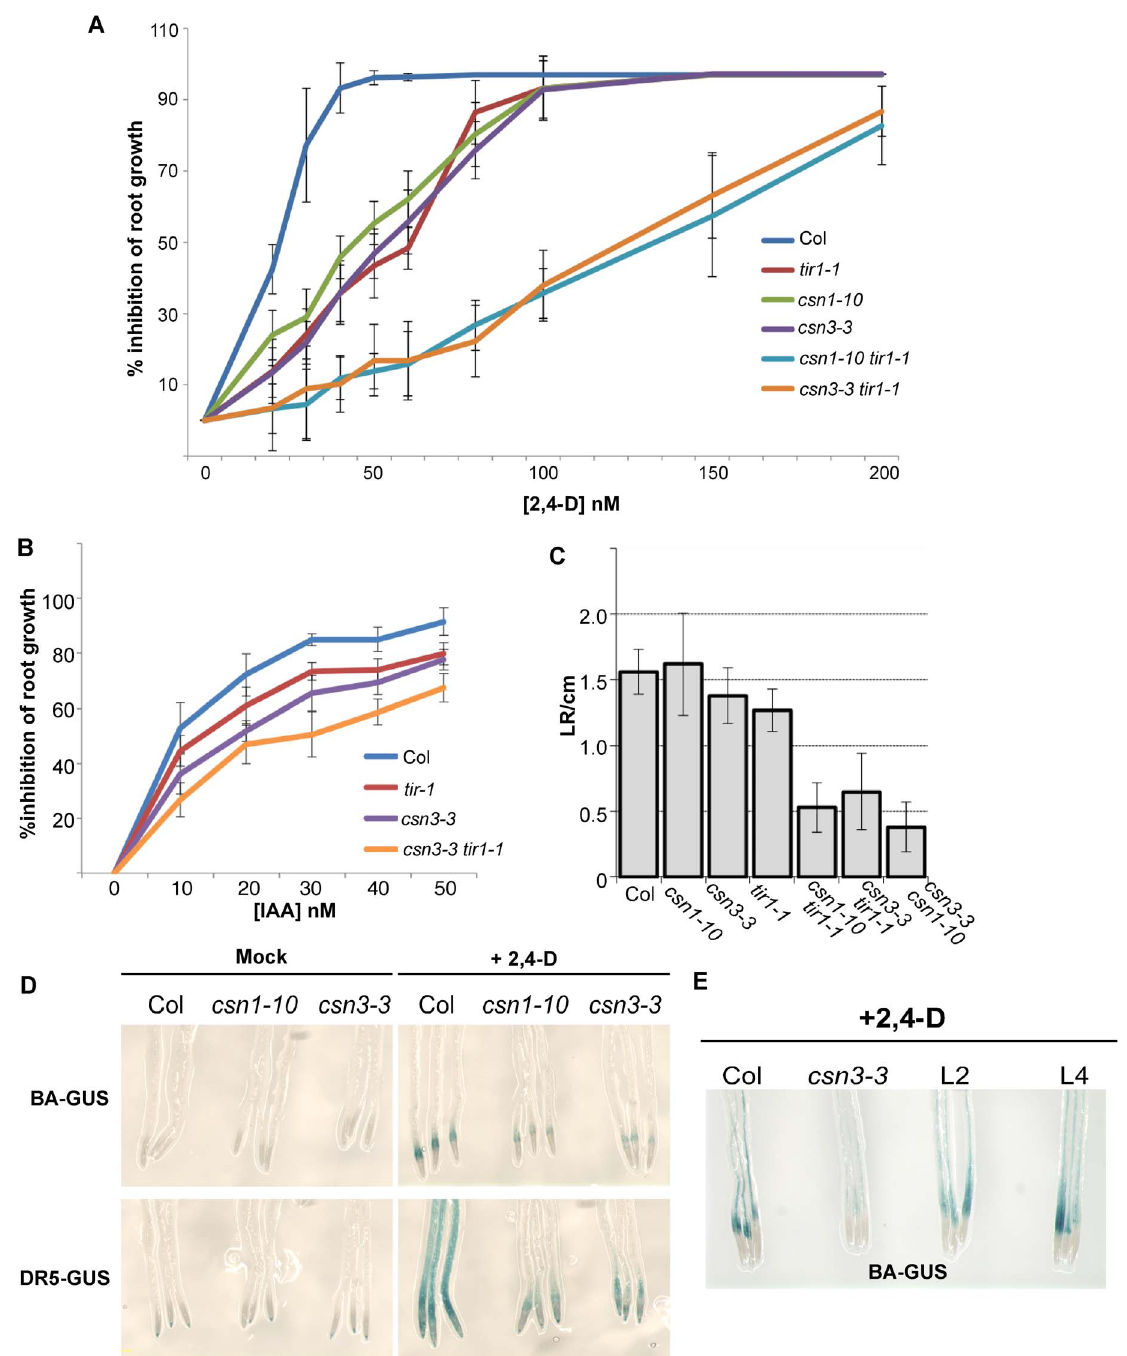
Figure 2. csn3-3 confers auxin response defects. ( A ) Inhibition of root elongation by increasing concentrations of the synthetic auxin 2,4-D. 5- day-old (d.o.) seedlings ( n $ 15) grown on ATS medium were transferred to medium containing 2,4-D and grown for another four days. Data are presented as percent inhibition of root growth compared to growth on unsupplemented ATS. Error bars=SD. ( B ) IAA dose-response curve of inhibition of root growth. ( C ) Lateral root (LR) initiation was measured in 11-d.o. seedlings grown on unsupplemented ATS medium. Data were presented as number of the lateral root initiations per cm root length. Error bars=SD ( n $ 15). ( D ) Transgenic Col, csn1-10 and csn3-3 carrying either the BA3 : GUS or DR5 : GUS reporters. 6-d.o. seedlings were treated with 0.5 m M 2,4-D for 12 h ( BA3 : GUS ) or 4 h ( DR5 : GUS ) before histochemical staining for b -glucuronidase activity. ( E ) Complementation of the reduced BA3:GUS expression phenotype of csn3-3 seedlings by a genomic CSN3 transgene. L2 and L4 are two independent csn3-3 [ gCSN3 ] transformants. doi:10.1371/journal.pone.0066578.g002 GUS construct, were heat-shocked at 37 u C for 2 hours to induce both qualitatively and quantitatively at 20 min intervals during the expression, followed by return to ambient temperature and treatment to monitor the remaining levels of AXR3NT-GUS treatment with auxin. AXR3NT-GUS activity was examined fusion protein ( Figure 4C, D) . Following the 2h heat-shock